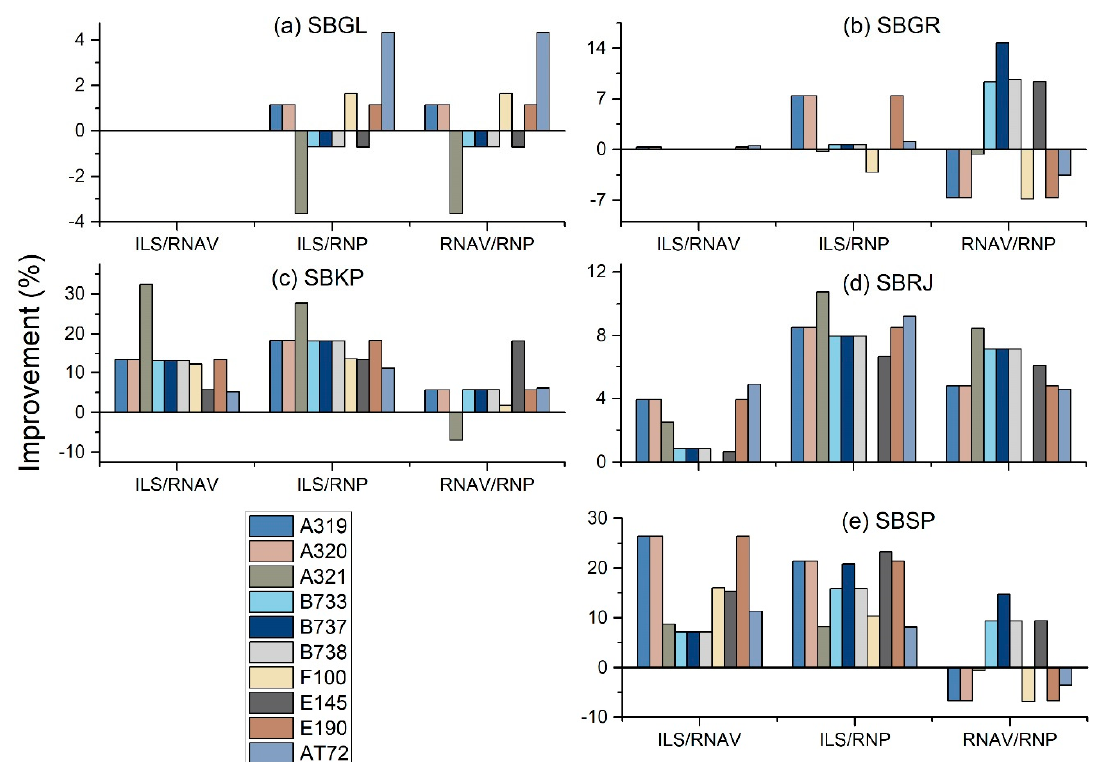
Figure 6. Case 1 approach; percentage improvement by airport. ( a ) SBGL; ( b ) SBGR; ( c ) SBKP; ( d ) SBRJ; ( e ) SBSP.